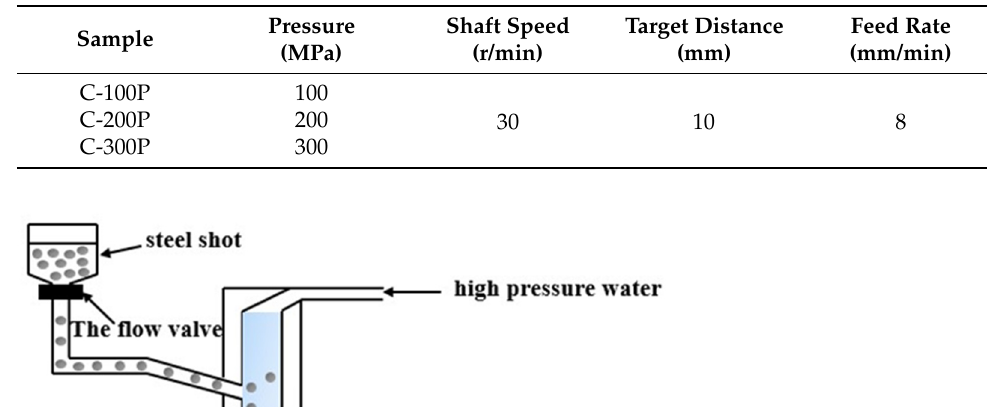
Table 4. Water jet parameters.